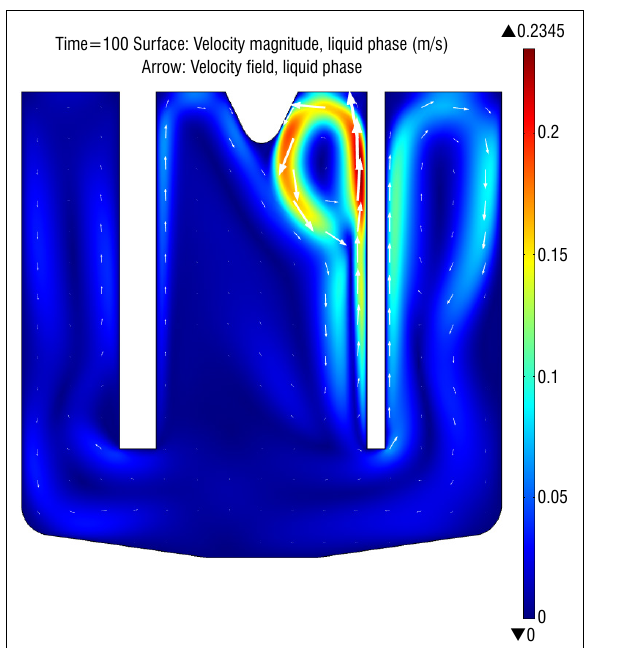
Figure 4: Liquid phase velocity inside the reactor.